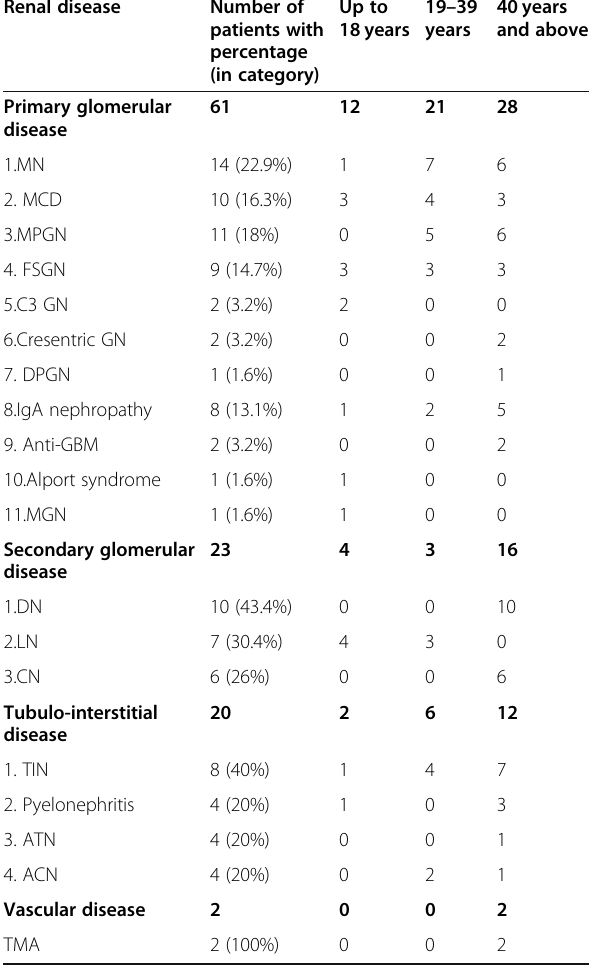
Primary glomerular disease is the predominant kidney disease in the northern region of India with MN being the most common single histopathological diagnosis. The spectrum of glomerular diseases varies widely de- pending upon a number of factors like age and sex, as well as the geographical mapping and the ethnic grouping.